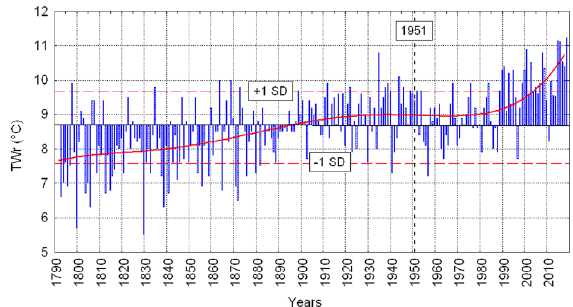
Fig. 2. The course of the annual air temperature in Wrocław (TWr) in the years 1791–2018 as a deviation from the long-term average. Continuous curve – adjustment of the polynomial to the power of 5 to the empirical courses. The year 1951 (vertical dotted line) is marked, the initial year of the period 1951–2018 analysed in detail. Horizontal dashed lines mark limits of the ±1 SD. SD – standard